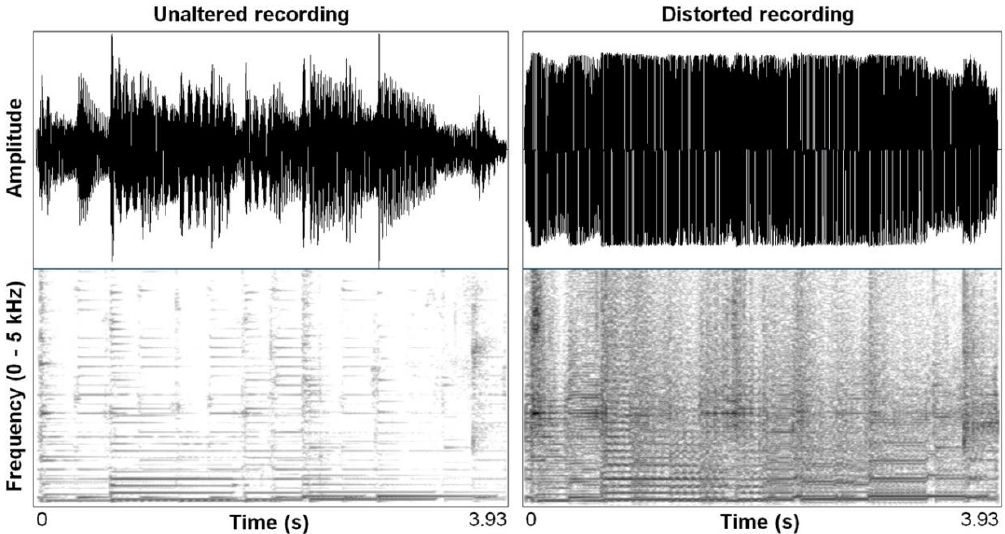
Figure 2. Waveform and spectrogram (Fast Fourier Transform (FFT) method, window length 0.005 s; Gaussian window shape, dynamic range 50 dB) of an acoustic guitar melody, unaltered (left) and distorted (right) using a wave shaping function (Camel Crusher VSY Plug-in). Reproduced without modification from Bryant, 2013. (Creative Commons Attribution Licence).